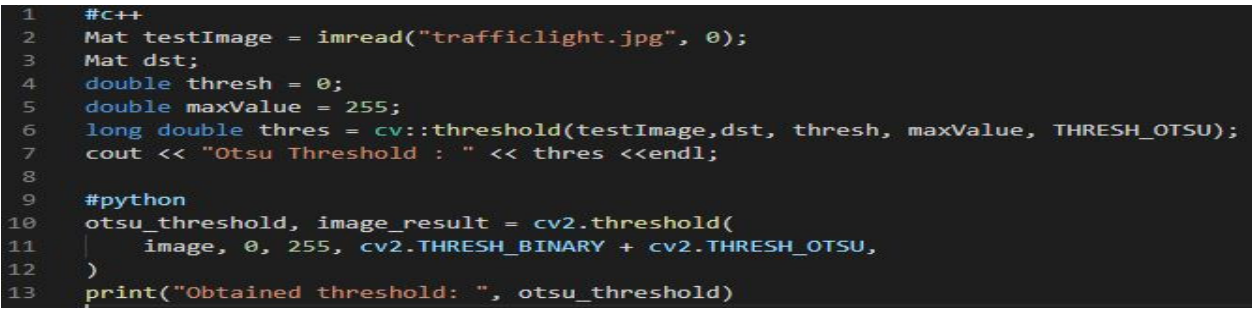
Figure 7. The code instance that imposes a threshold on internal class variables.